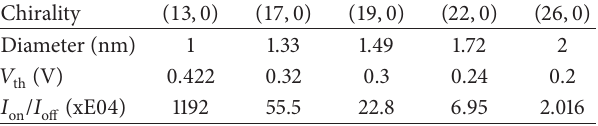
Table1:Showingdifferentdiametervalueswith 𝑉 th and 𝐼 on / 𝐼 off ratio.